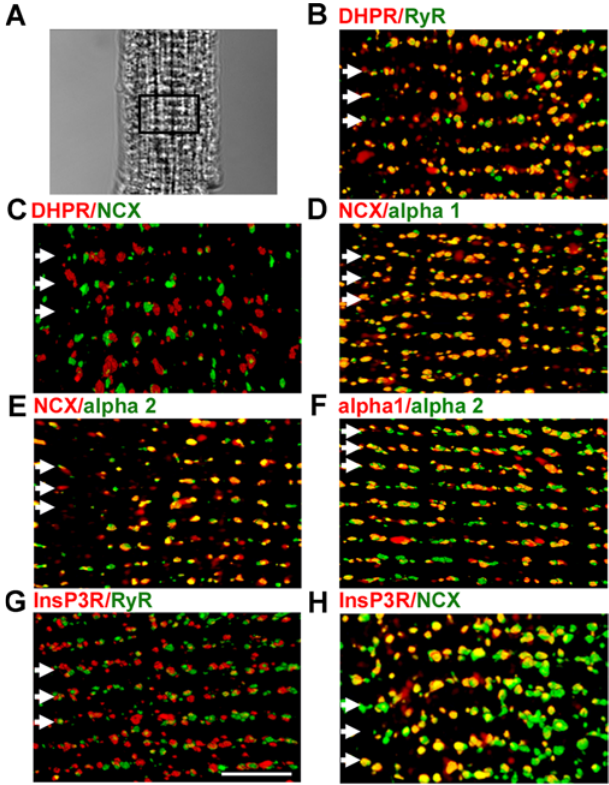
Figure 2. The Ankyrin-B-Based Complex of NKA, NCX1, and InsP 3 R Is Localized in a Specialized T-Tubule Microdomain of Cardiomyocytes Adult cardiomyocytes were labeled with indicated antibodies. 3D reconstructions of each cell (A, differential interference contrast) are shown for each combination. Staining pairs include (B) DHPR (red) and RyR (green), (C) DHPR (red) and NCX (green), (D) NCX (red) and NKA alpha1 (green), (E) NCX (red) and NKA alpha 2 (green), (F) NKA alpha 1 (red) and NKA alpha 2 (green), (G) InsP 3 R (red) and RyR (green), and (H) InsP 3 R (red) and NCX (green). Voxel co-localization was performed for non-sarcolemmal voxels. T-tubule/Z-lines are indicated by white arrows.